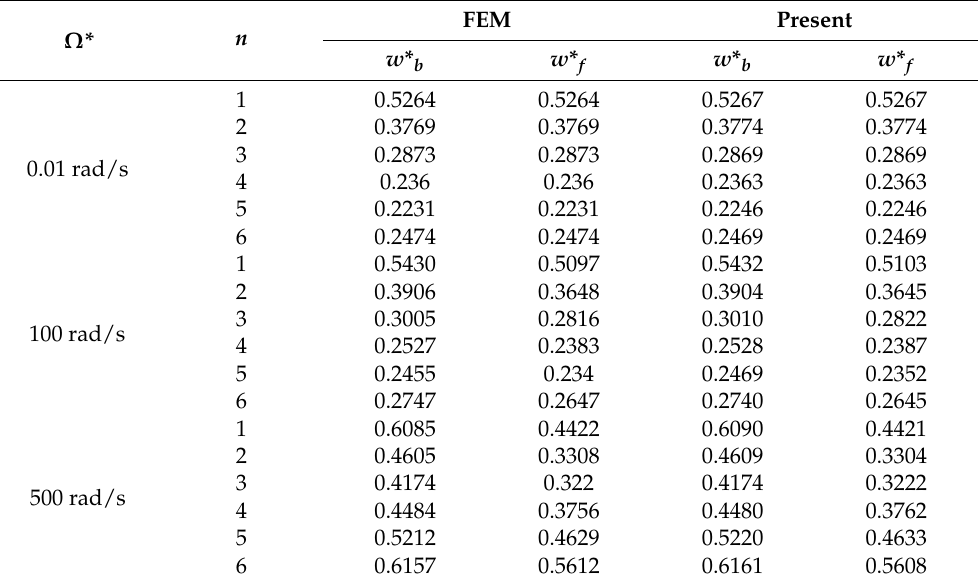
Table 3. Comparison of dimensionless frequencies for a rotating isotropic combined conical- cylindrical shell.